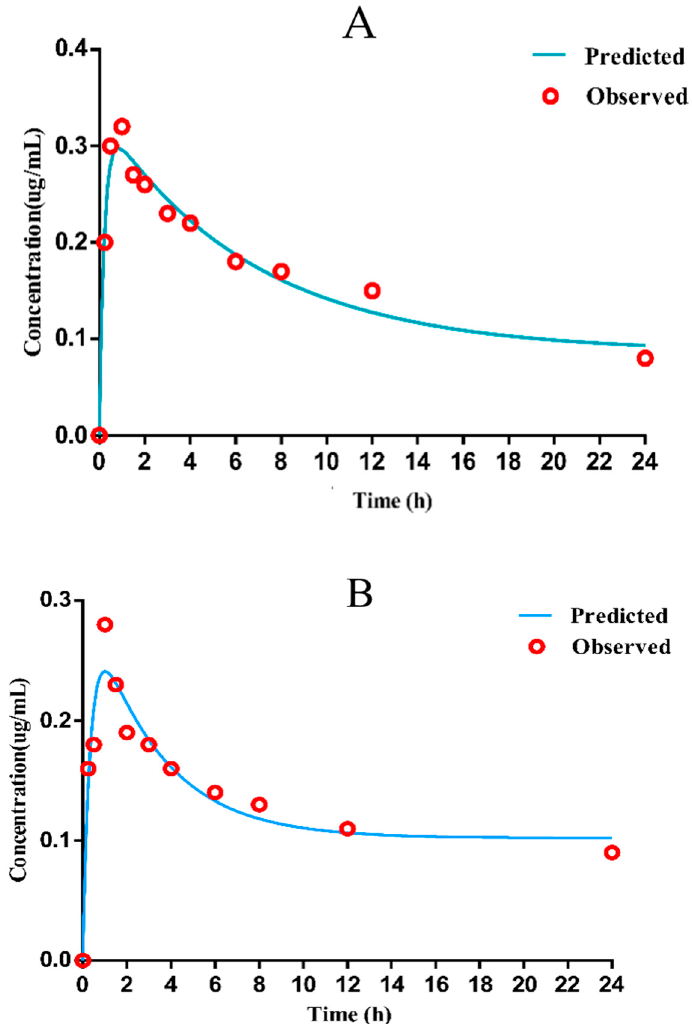
Figure 4. Mean concentration versus time for danofloxacin in healthy and diseased lung (( A ): healthy lung ( B ): diseased lung).